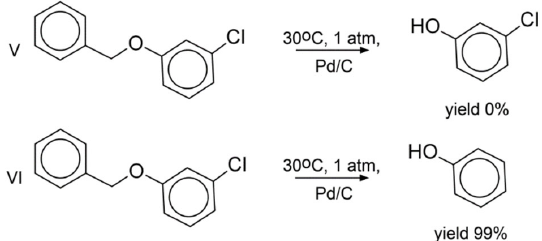
Figure 4. Regioselective reduction of 1 ‐ benzyloxy ‐ 3 ‐ chlorobenzene. The same conditions were predicted for reactions V and VI: medium t, low p, palladium on carbon. As a result, Reaction VI was carried out with the yield 99%, 1% was the incomplete reduction